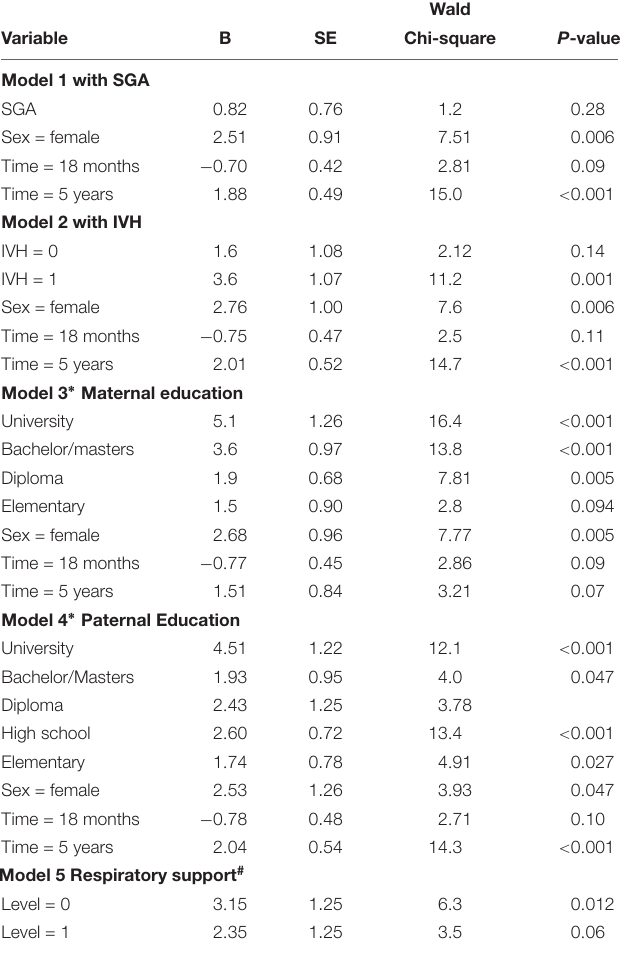
TABLE 6 | Results of GEE multivariable analysis with parameter estimates, standard errors and Wald Chi square for the cohort for the dependent variable cognitive